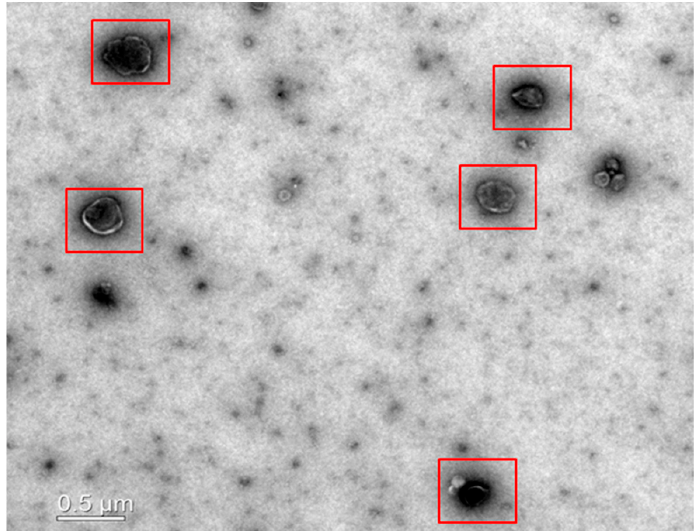
Figure 1. Transmission electron micrograph showing exosomes (red boxes) isolated from conditioned medium derived from canine adipose-derived mesenchymal stem cells (Ad-MSCs).